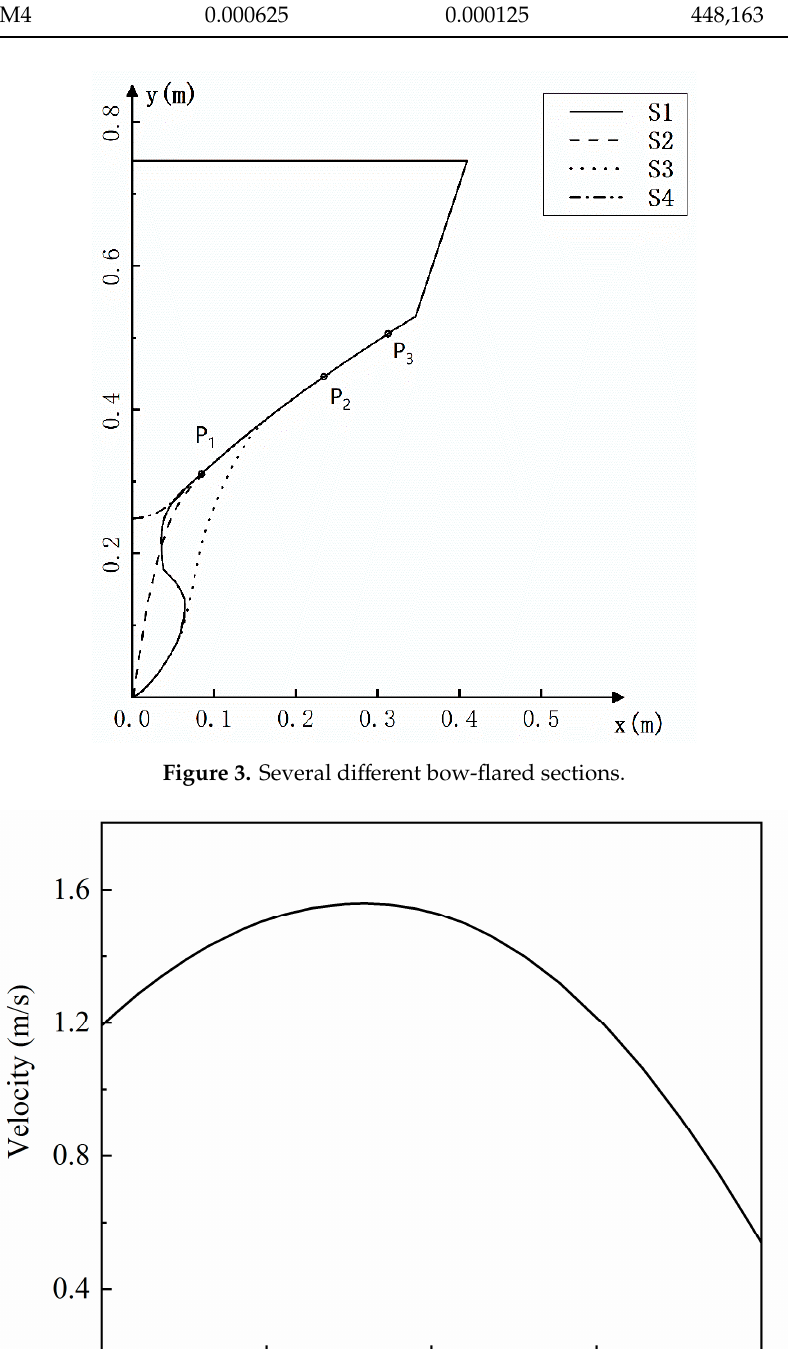
Figure 4. Velocity curve of the bow-flared section.